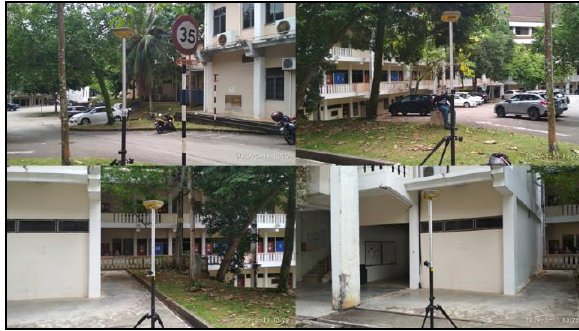
Figure 2 . GPS observation at point 4(6)